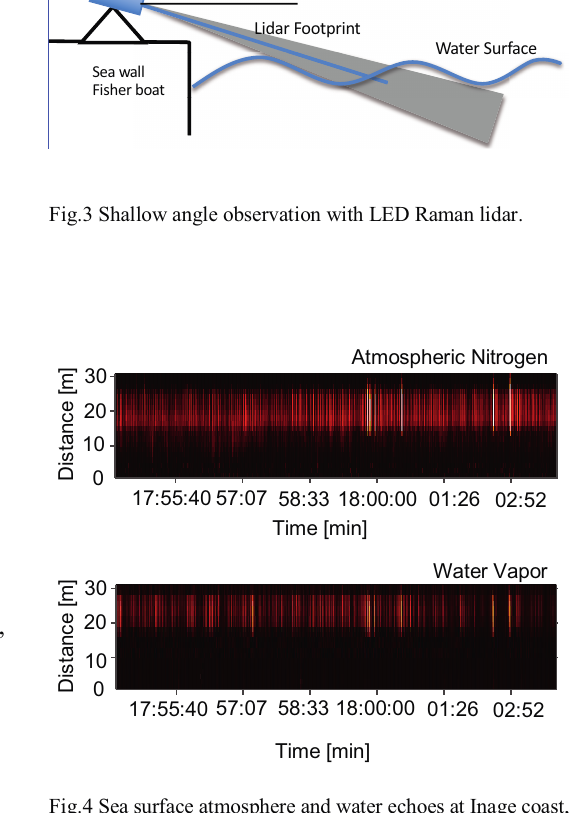
Fig.4 Sea surface atmosphere and water echoes at Inage coast, Chiba, Japan on 28 th Dec. 2018.